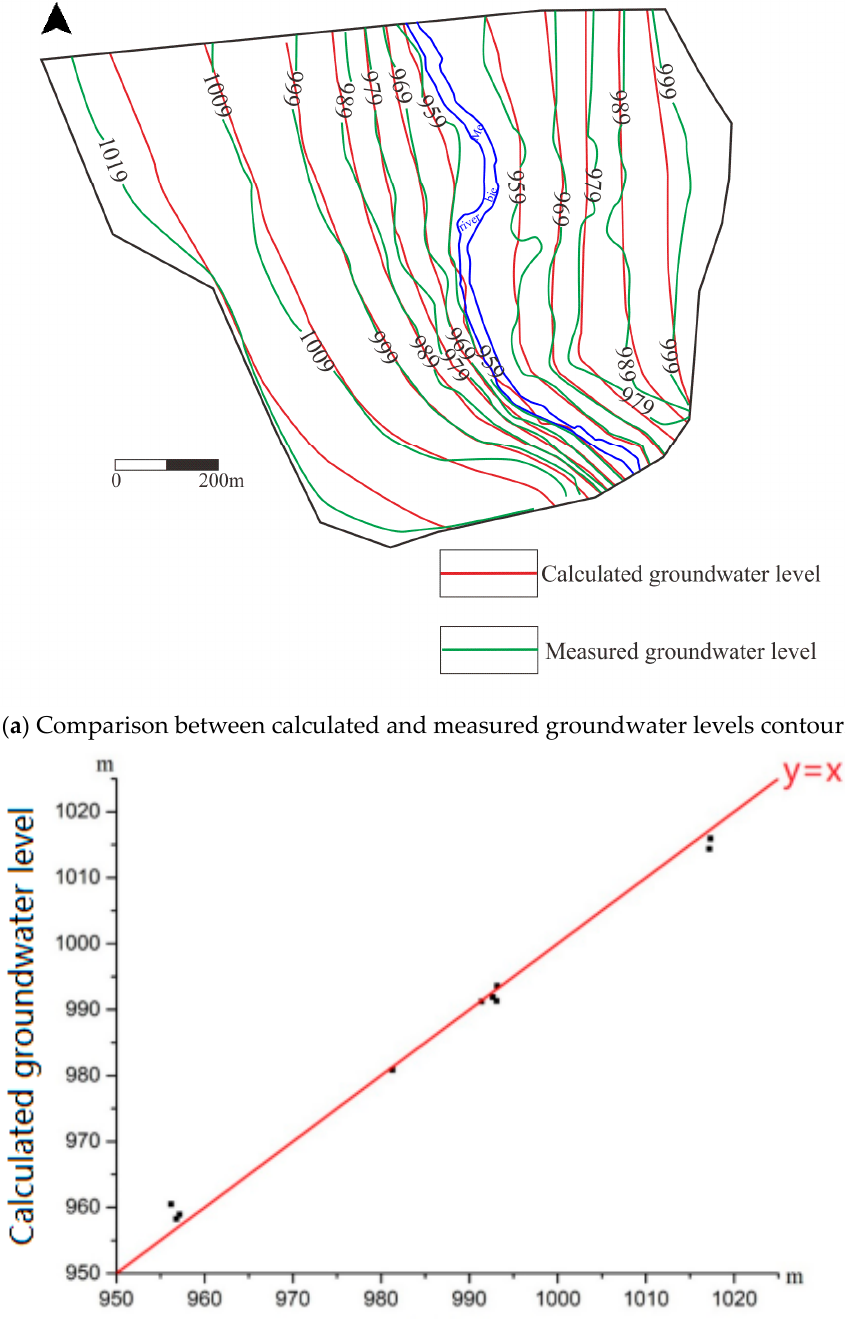
Figure 7. Calculated and measured values of groundwater levels. ( a ) Comparison between calculated and measured groundwater levels contours. ( b ) Fitting curve between calculated and measured groundwater